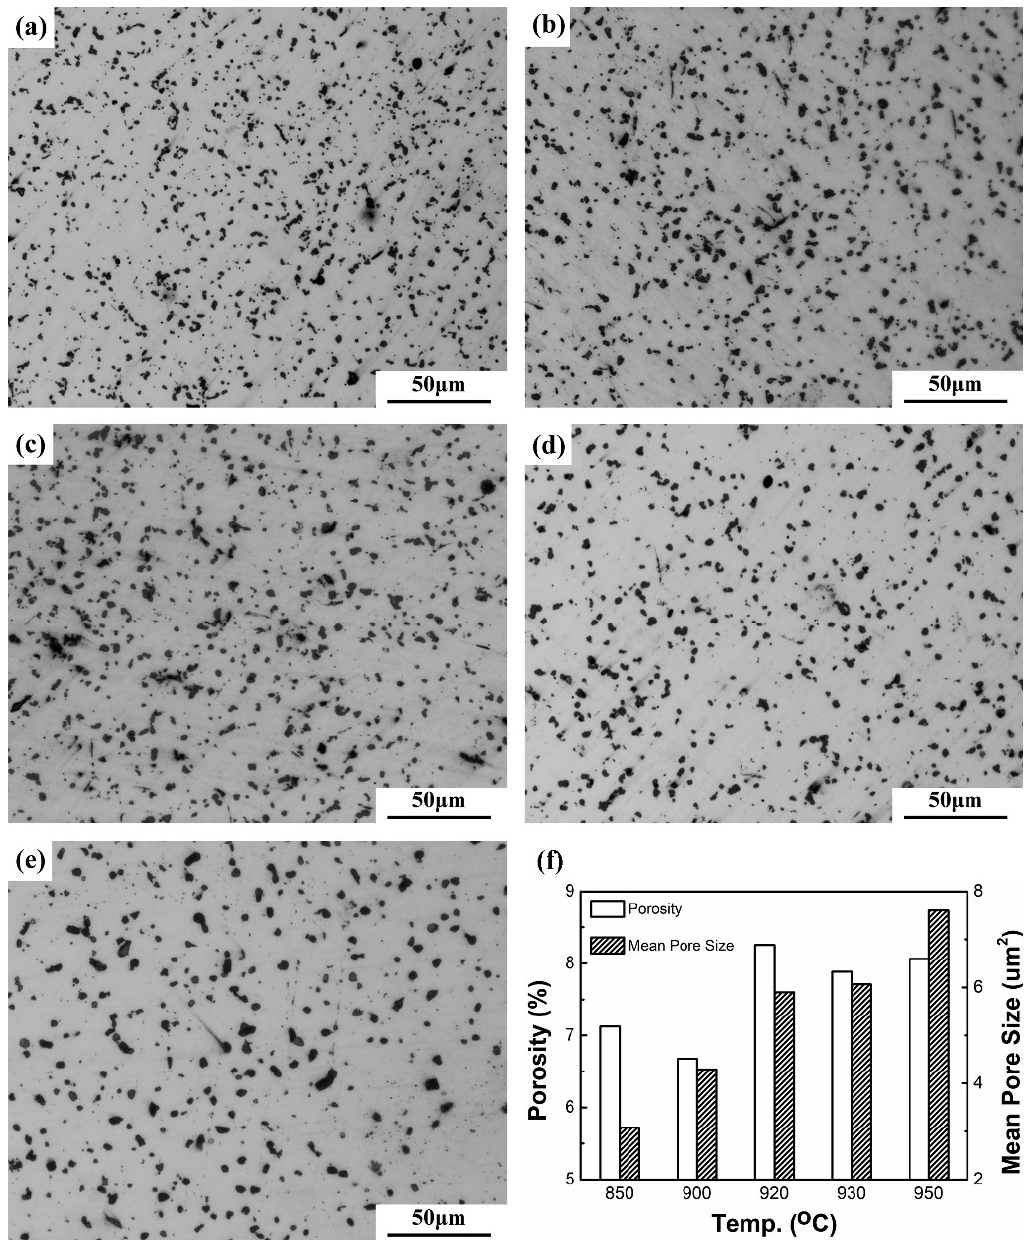
Figure 3. Optical micrographs of un-etched Cu samples sintered at ( a ) 850 ◦ C, ( b ) 900 ◦ C, ( c ) 920 ◦ C, ( d ) 930 ◦ C and ( e ) 950 ◦ C. ( f ) The porosity content and mean pore sizes of the samples. In order to reveal grain structures, the sintered samples were etched and observed by an